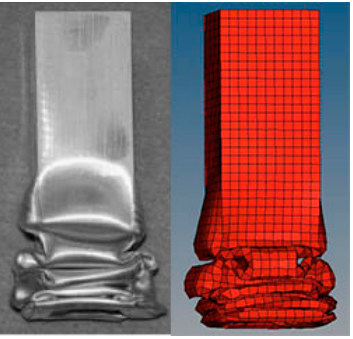
Figure 10. Comparison of deformation patterns of structure between experimental and numerical results.